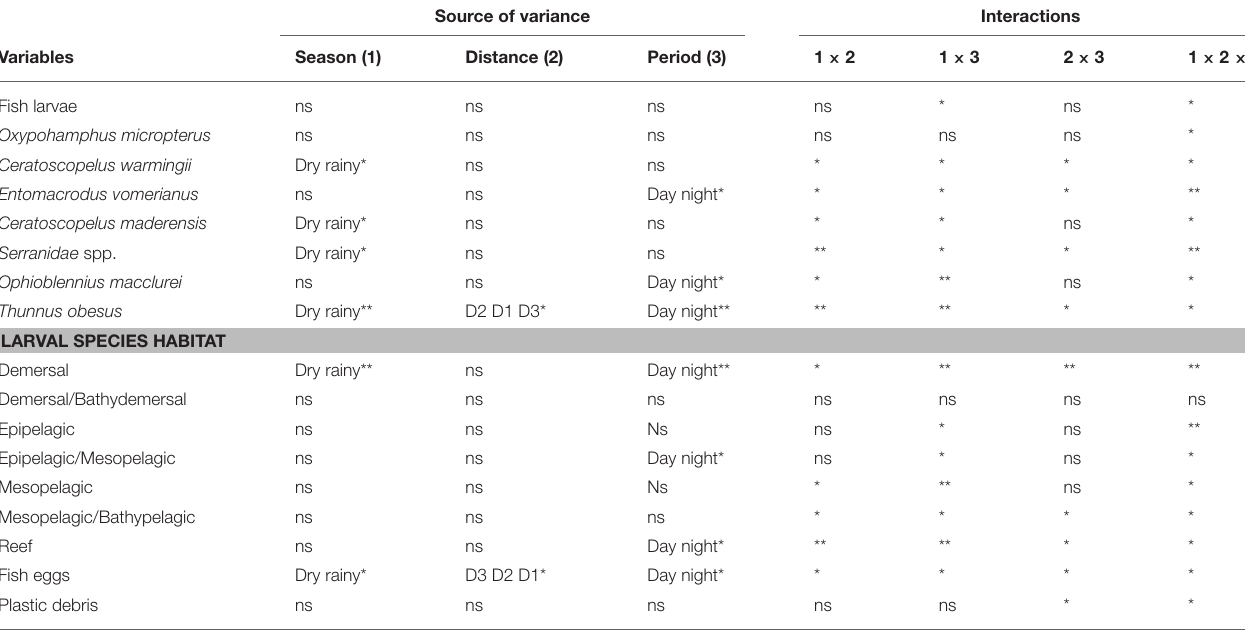
TABLE 2 | Summary of the ANOVA results for the mean density of fish larvae, fish eggs, and plastic debris. Source of